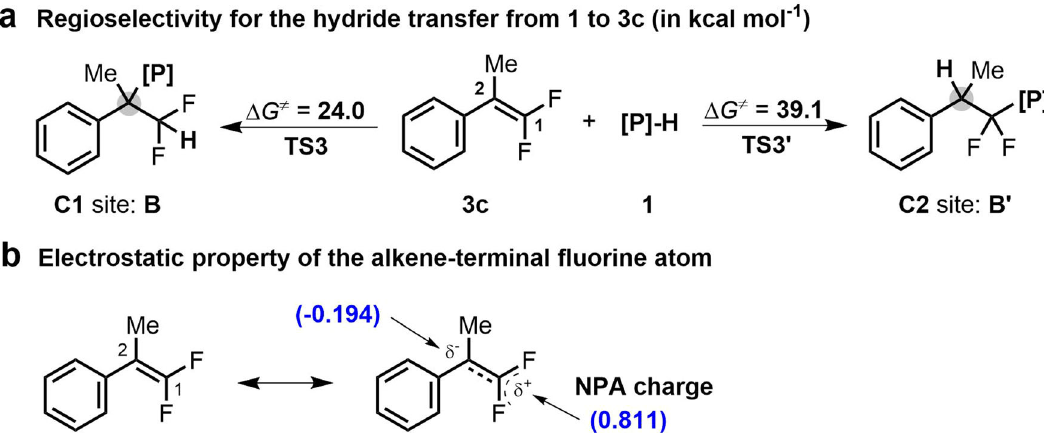
Fig. 8 Rationalization of the regioselectivity of hydride transfer from diazaphospholene 1 to 3c. a Regioselectivity for the hydride transfer from 1 to 3c . b Electrostatic property of the alkene-terminal fl uorine